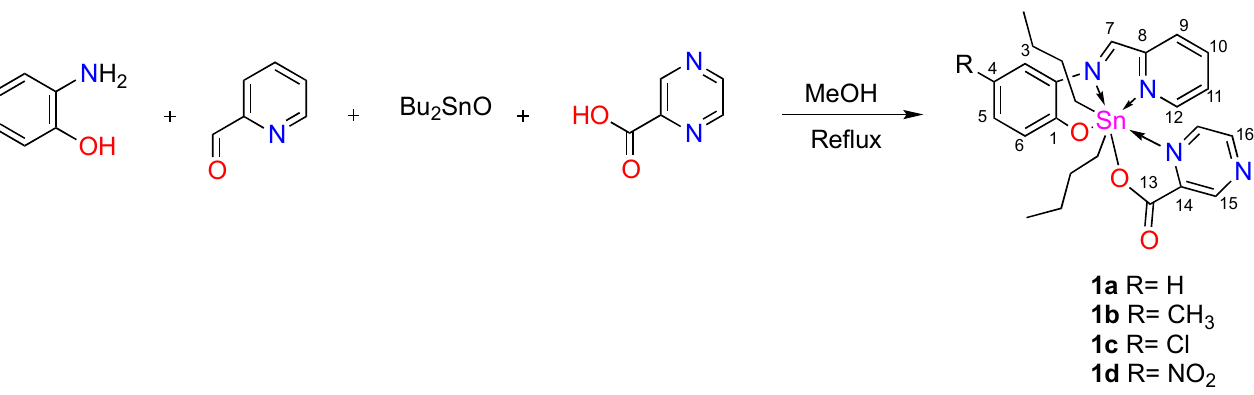
Figure 1. Synthesis of heptacoordinated organotin (IV) complexes.